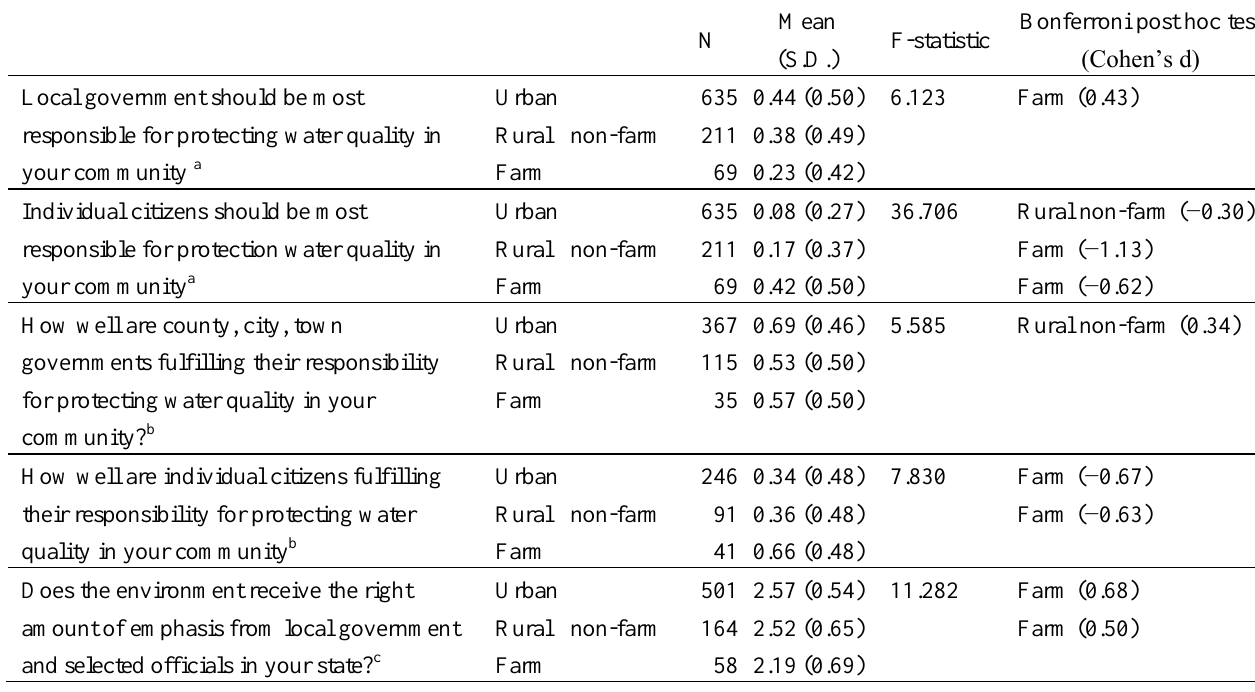
Table 4. Comparisons of beliefs about the protection of local waters among urban, rural non-farm and